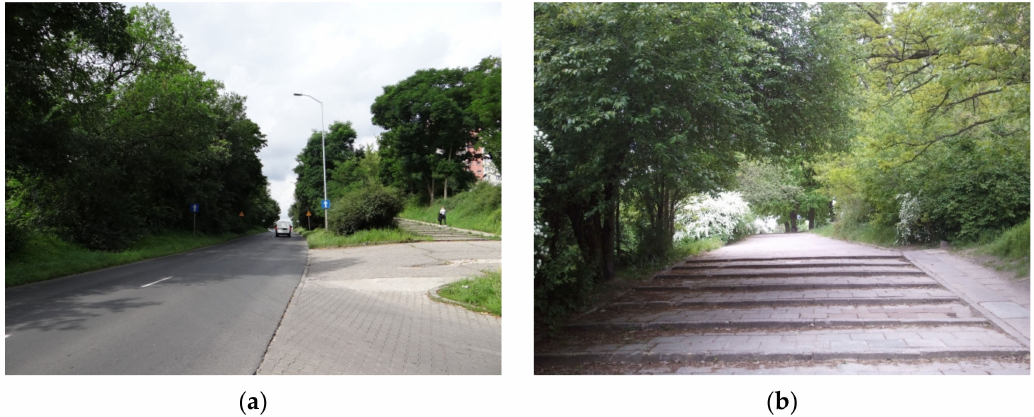
Figure 13. Layered vegetation on the approach to the analysed intersection along the westbound carriageway: ( a ) View of the approach to the intersection; ( b ) View of layered vegetation from both sides of the walkway running behind the slope of the road cut.